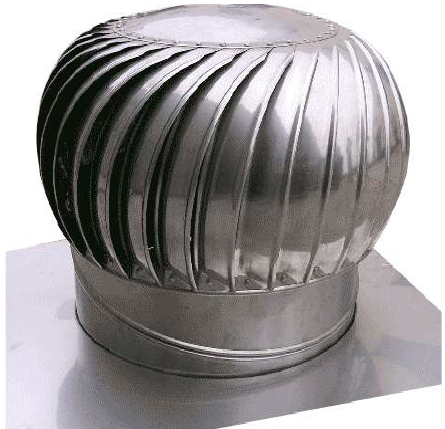
Figure 5. Photo of frequency modulator. Figure 6. Photo of QM-600 swirl natural ventilator.